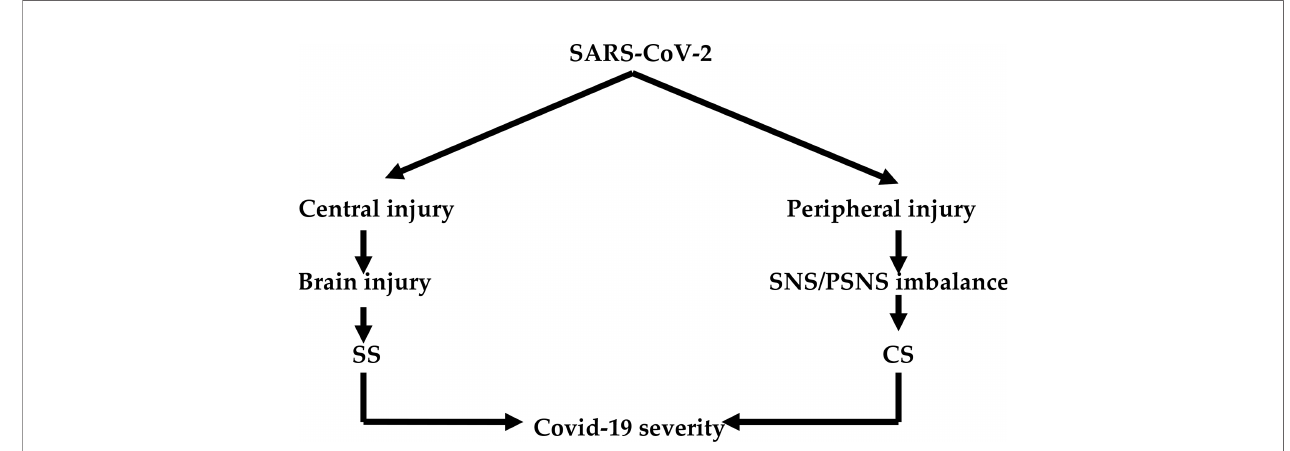
FIGURE 1 | SARS-CoV-2 infection and development of sympathetic and cytokine storms: Central effect of SARS-CoV-2 leads to brain injury and development of sympathetic storm (SS). The peripheral effect of SARS-CoV-2 leads to induction imbalance between the sympathetic nervous system (SNS) and parasympathetic nervous system (PSNS) and development of cytokine storm (CS). Both SS and CS lead to Covid-19